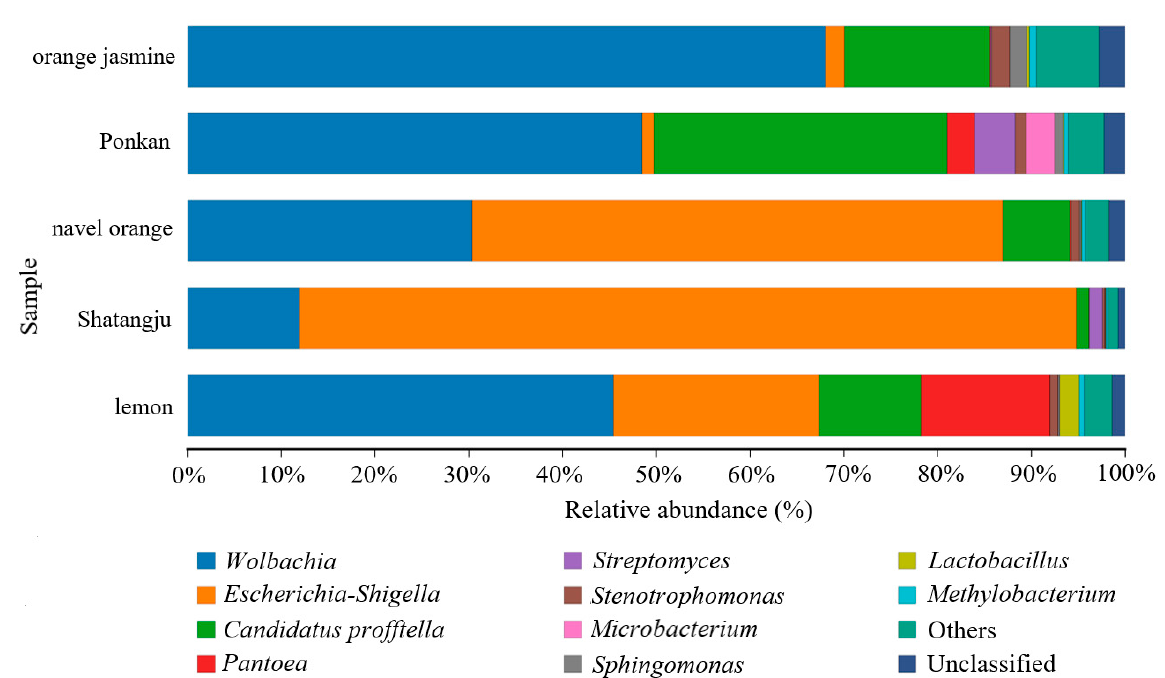
Figure 2. Relative abundance of families in D. citri gut. Only the taxa within the 10 most abundant were considered.